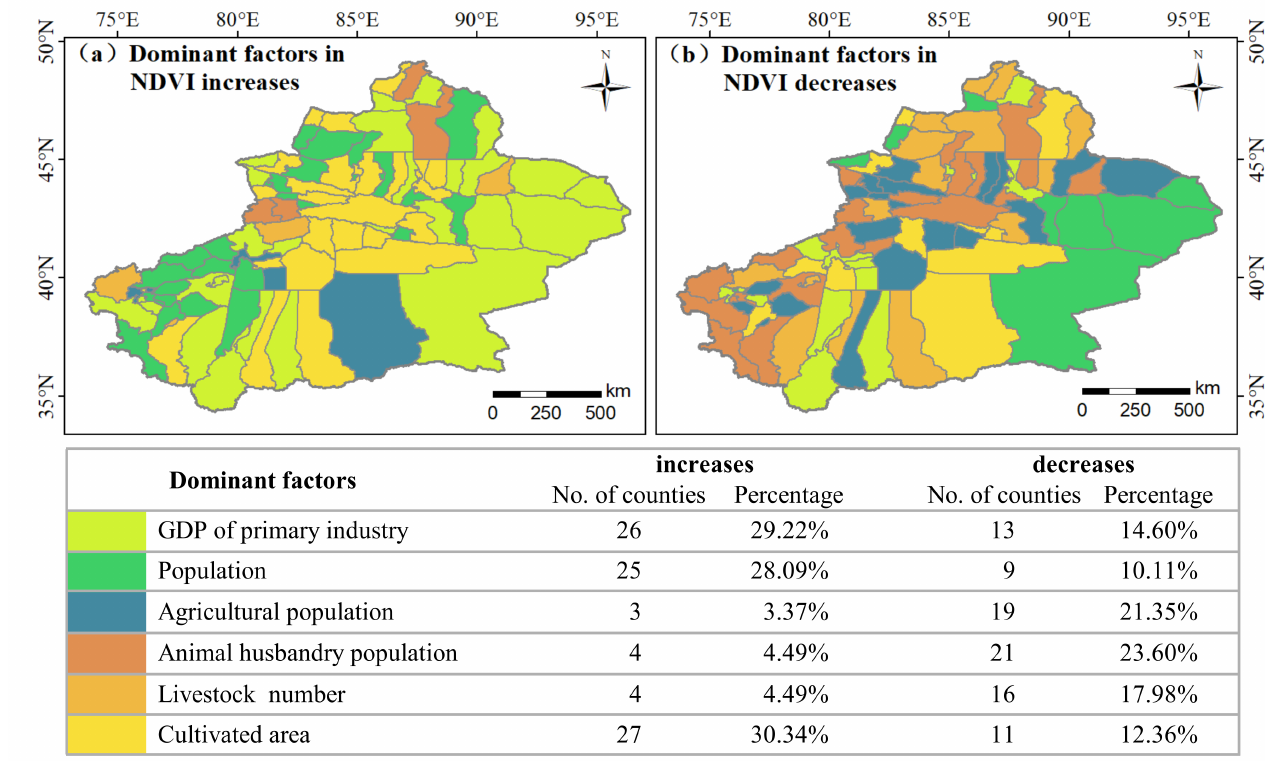
Figure 8. The anthropogenic dominant factor for the increase ( a ) and decrease ( b ) of NDVI for each county in